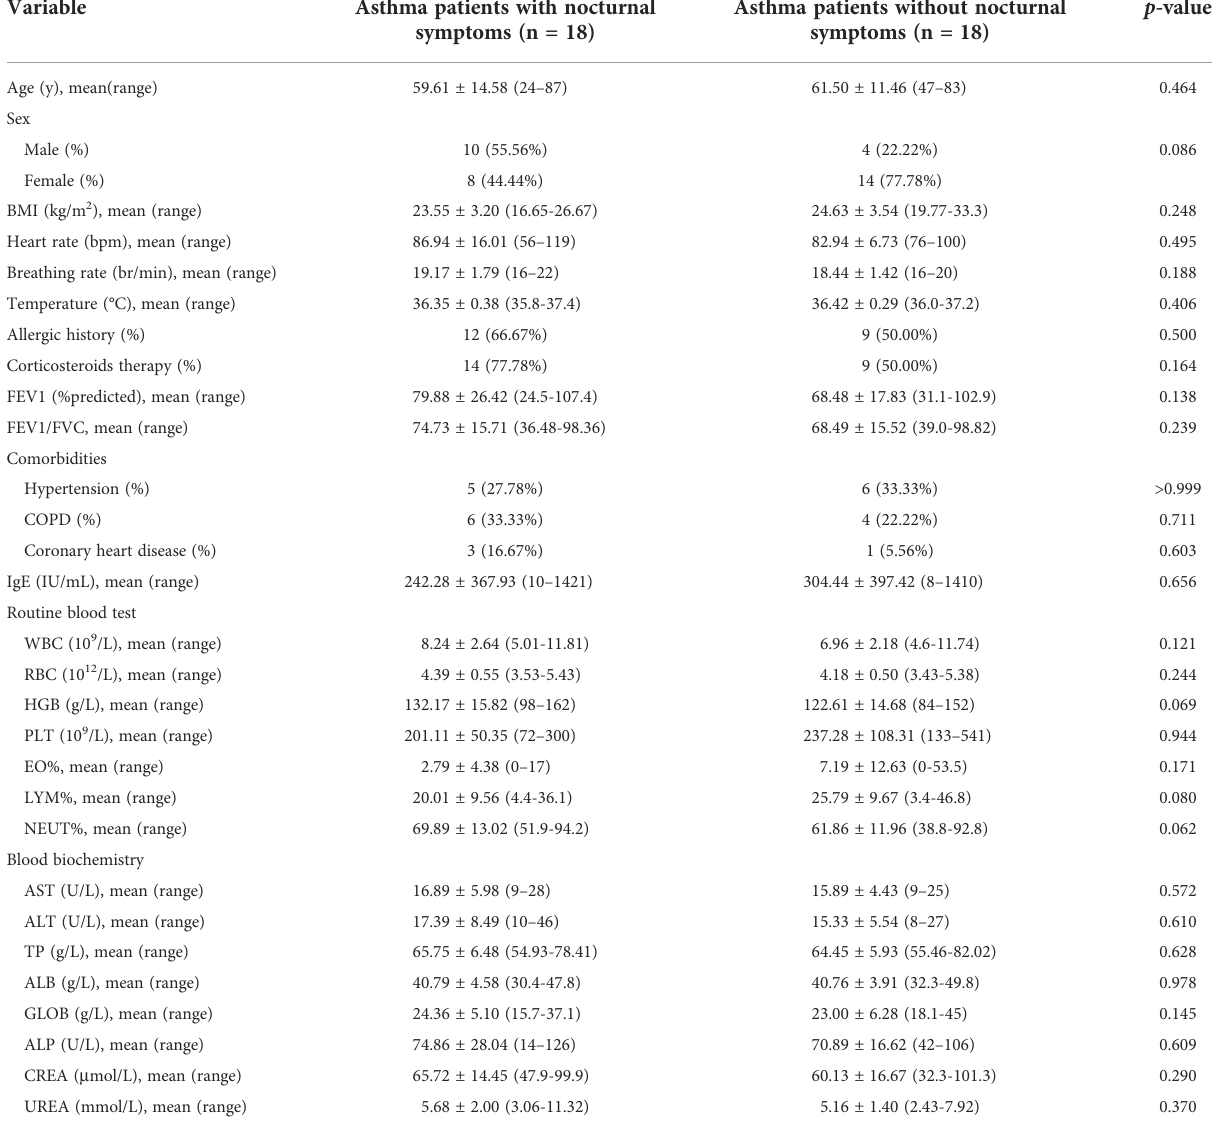
TABLE 1 Demographic and clinical characteristics of the